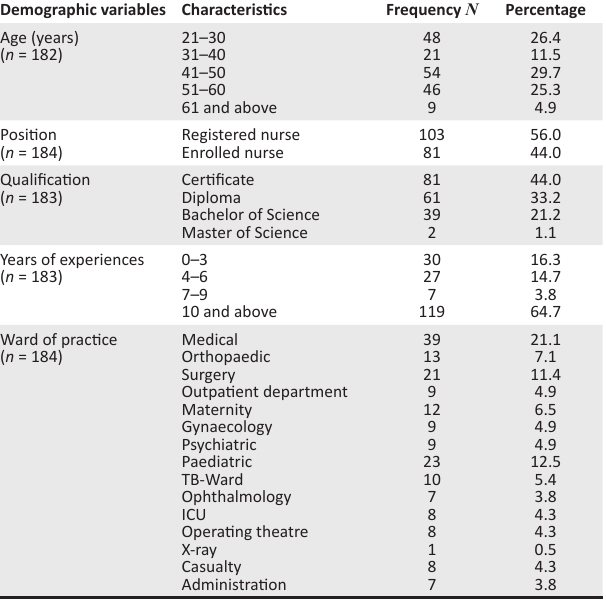
TABLE 1: Socio-demographic characteristics of participants. Demographic variables